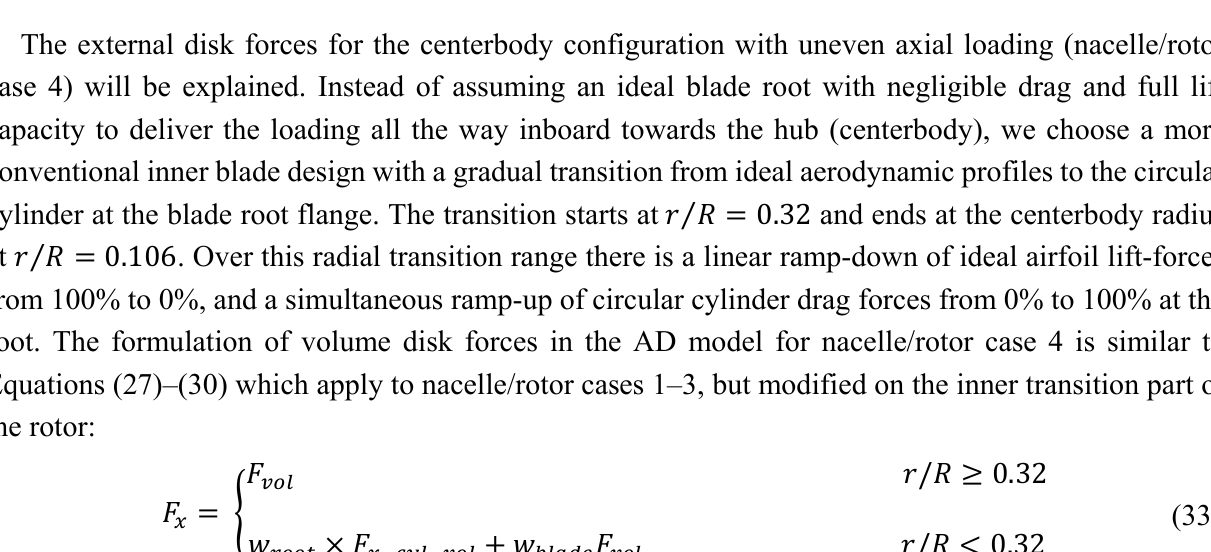
Figure 13. ( a ) Mesh zoom-in; ( b ) Zoom-in of left zoom-in. The blue subdomain is the AD